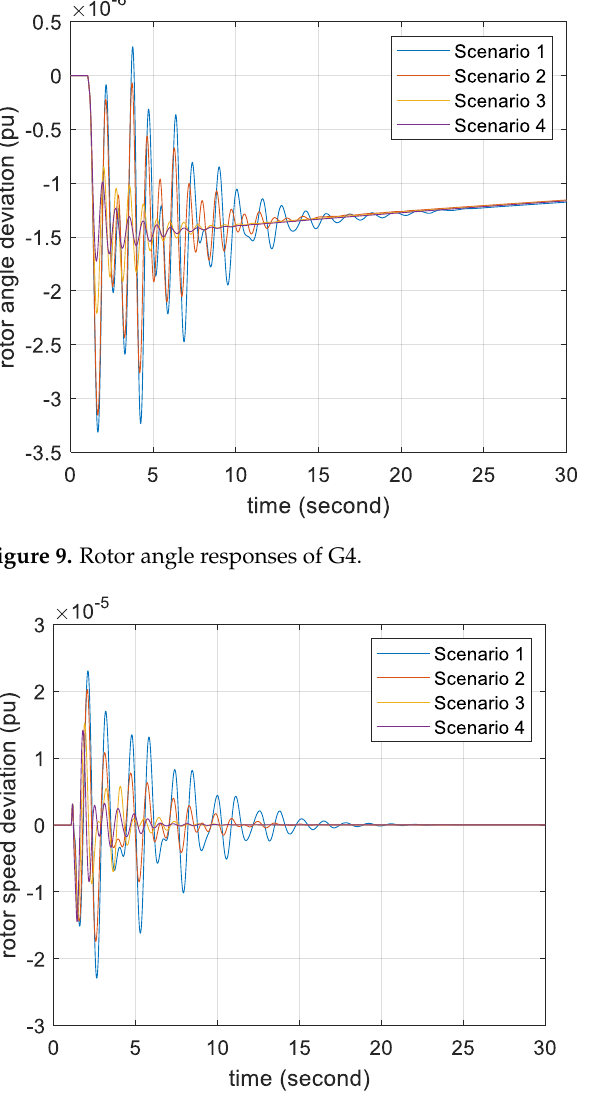
Figure 10. Rotor speed responses of G3.